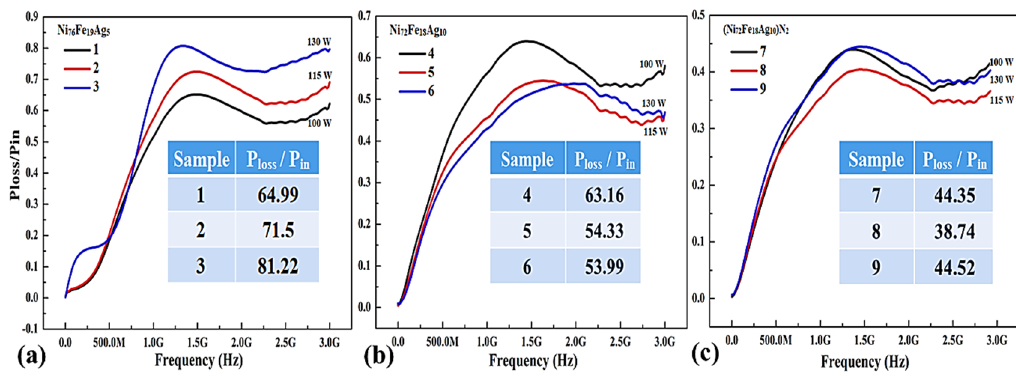
Figure 7. Power loss for flexible thin films ( a ) Ni 76 Fe 19 Ag 5 thin films deposited using Ar and varying sputtering power; ( b ) Ni 72 Fe 18 Ag 10 thin films deposited using Ar and different sputtering power; and ( c ) Ni 72 Fe 18 Ag 10 thin films prepared with N 2 +Ar gas mixture using different nitrogen flow rate.